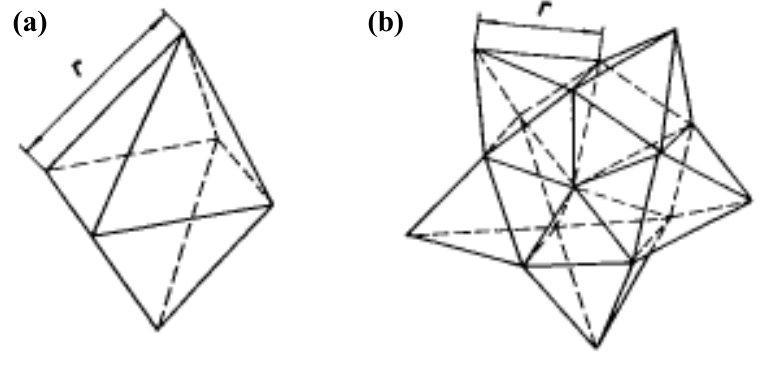
Figure 5. Schematic of different primary Si in Al-Si alloys [19]: ( a ) octahedron; ( b ) star-like